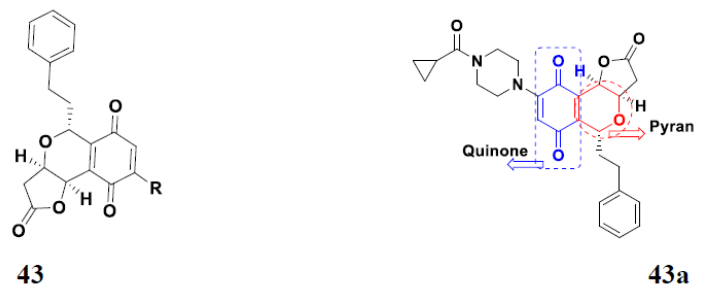
Jiang et al. (2015) synthesized quinone based pyran hybrids and evaluated their anticancer activity. Most of the synthesized compounds showed potent anticancer activity. Among them, compound 43 ( a ) showed excellent activity against KB (throat cancer cells), KB/VCR (colon cancer cells), A549, and HL60, with IC 50 values 4.05, 1.28, 0.62, and 1.73 µ g/mL. A control vincristine had IC 50 values of 0.46, 0.26, and 12.09 µ g/mL (for KB, KB/VCR, A549), respectively, and adriamycin had an IC 50 value 0.02 µ g/mL (HL60). The structure of quinone-based pyran hybrid derivatives is given in Figure 48 and the in vitro cytotoxicity ( µ g/mL) of compounds 43 ( b – e ) against human cancer cell lines is shown in Table 36 [104].